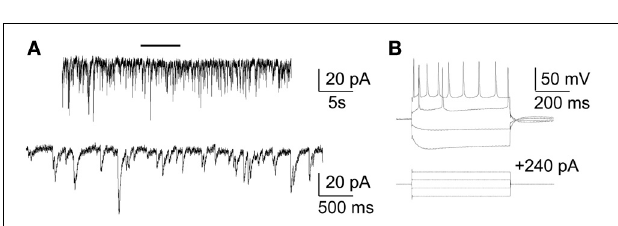
FIGURE 2 | Neurons cultured on silicon chip exhibit typical electrophysiological properties. (A) Representative whole-cell voltage-clamp recording showing spontaneous EPSCs. Recording was performed at holding potential of − 70mV. Data were filtered at 2kHz (1kHz for presentation) and digitized at 20kHz. Similar sEPSCs were observed in 3–4 neurons each from 3 independent cultures ( n = 11). (B) Whole-cell current-clamp recording. The resting membrane potential of this neuron was − 65mV (not corrected for junction potential). Action potential in response to current injection. Similar results were observed in 3–4 neurons from 4 cultures ( n =